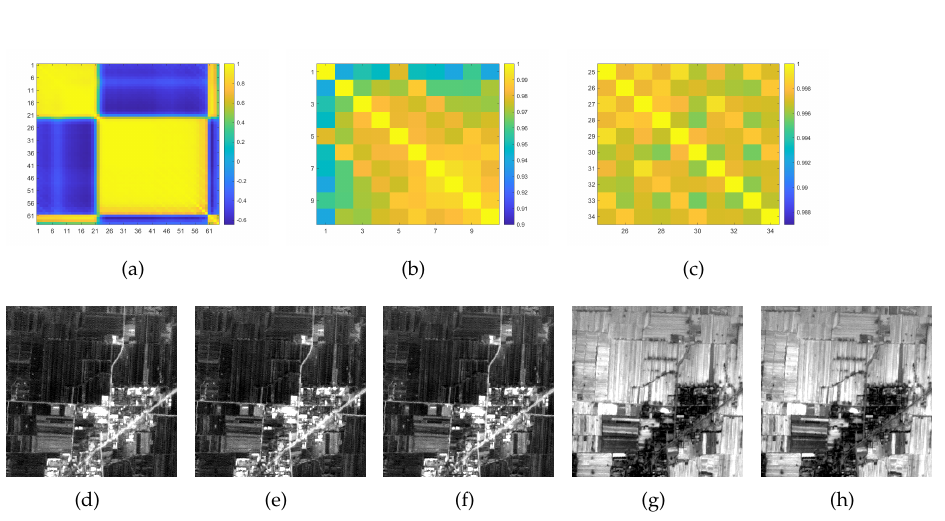
Figure 4. For the Xi’an data with 64 bands, ( a ): the correlation coefficient image between all bands with a size of 64 × 64 (a larger value indicates a higher correlation); ( b ): the correlation coefficient image of Band 1–10; ( c ): the correlation coefficient image of Band 25–34; ( d – h ): the gray image for Band 6–8, 26-27. The corresponding correlation coefficient between Band i and j (denoted ρ i , j ) are attached: ρ 6,7 = 0.9855, ρ 6,8 = 0.9867, ρ 7,8 = 0.9928, ρ 26,27 =